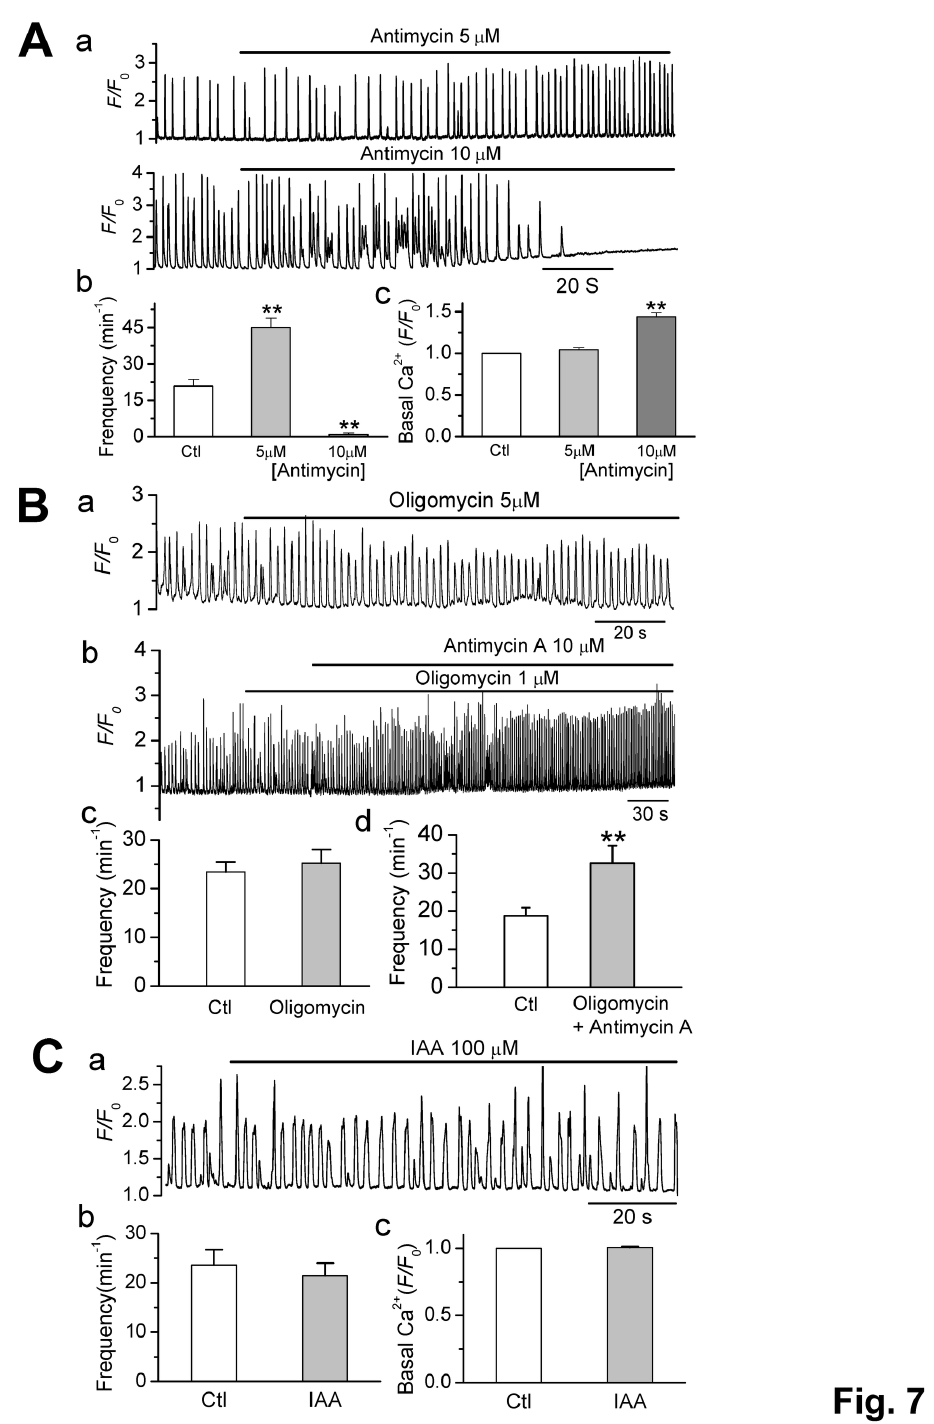
Figure 7. Metabolic inhibition exhibited less direct effect on CaWs. A . The effect of antimycin A (an electron transport chain inhibitor disrupting Δ Ψ ) on CaW frequency and basal [Ca i2+ ] level. Representative traces (5 and 10 µM antimycin A) (A- a ) and m summarized data (A-b & c) are shown. ∗∗ p < 0.01 vs. control (n=6). B . The effects of oligomycin alone (B-a) and in the presence (B-b) of high-dose antimycine A (10 µM) on CaWs. B-b & c. Summary data showing the CaW frequencies under each condition. (n = 5 for each, ∗∗ p < 0.01 vs. control). C . the same as A, except for Iodoacetic acid (IAA, a glycolytic inhibitor, n = 7) was tested. IAA exerted no significant effects on CaWs or basal [Ca i2+ ] ( p > 0.05). doi: